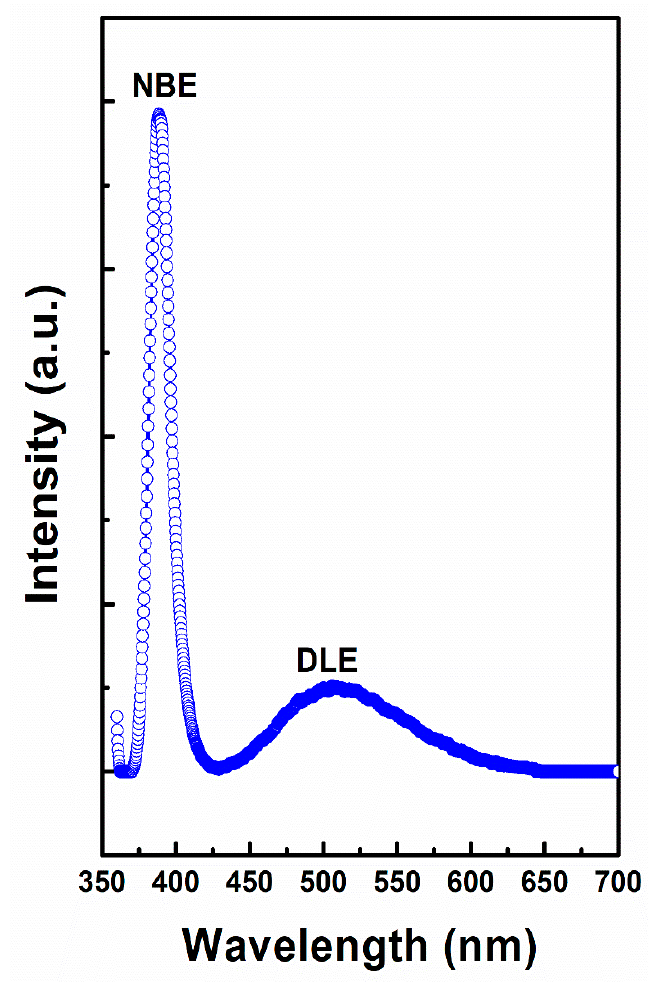
Figure 5. Photoluminescence spectrum of ZnO nanorods at room temperature.